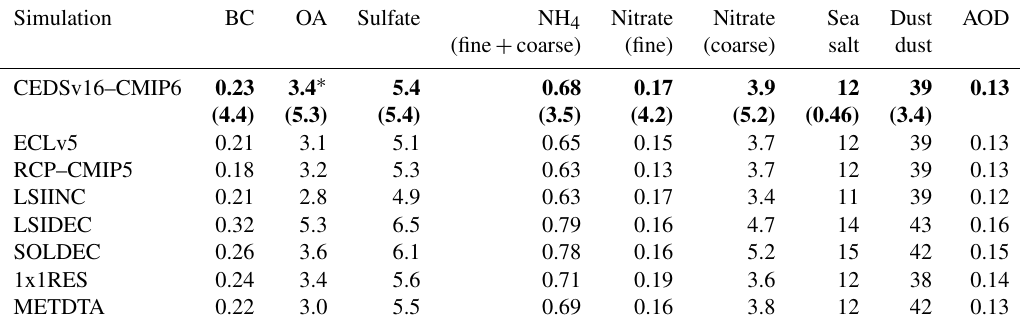
Table 3. Global annual mean aerosol burdens (mgm − 2 ) and total AOD in the baseline and sensitivity simulations. Parentheses in the top row give the atmospheric residence time (ratio of burden to total wet plus dry scavenging) (days). Corresponding values for the sensitivity simulations are given in Table S3. Results from the baseline CEDSv16–CMIP6 simulation are shown in bold. Simulation BC OA Sulfate NH 4 Nitrate Nitrate Sea